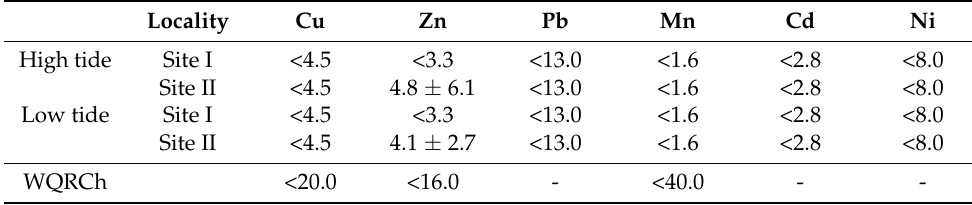
Table 2. Heavy metal concentration in water from the Valdivia River estuary ( µ g/L) (winter, July 2010). WQRCh: Water quality regulations in Chile (maximum levels allowed in the Valdivia River